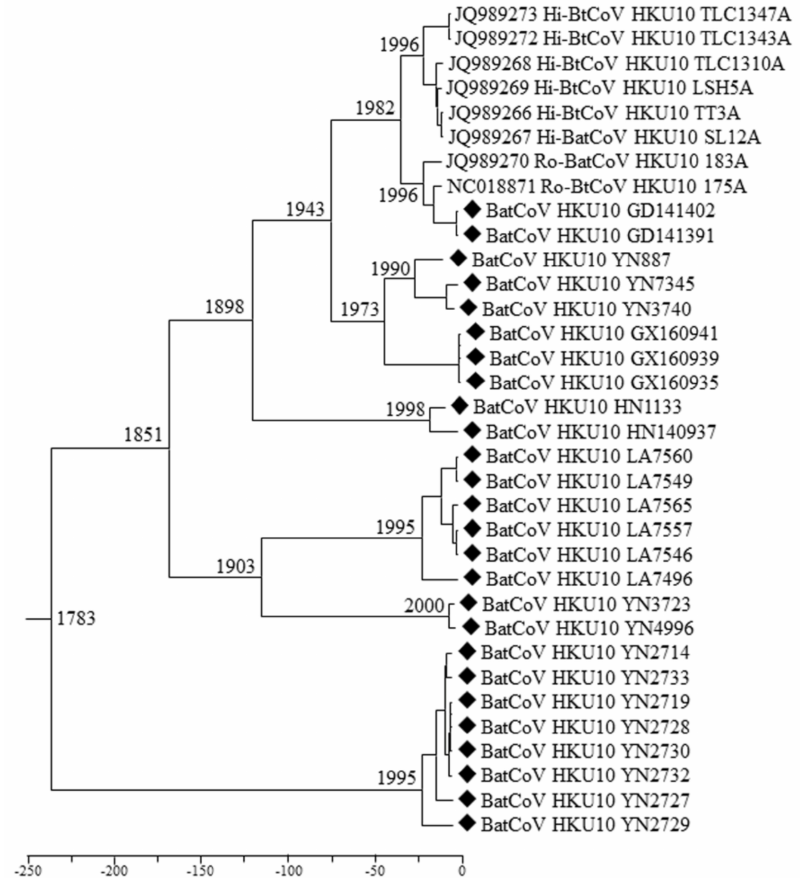
Figure 6. Estimation of the tMRCA of BtCoV HKU10. The time-scaled phylogeny was summarized from all MCMC phylogenies of the RdRp gene data set analyzed under the relaxed-clock model with an exponential distribution (Uced) in BEAST version 2.4.4. Filled diamonds indicate viruses detected in this study.